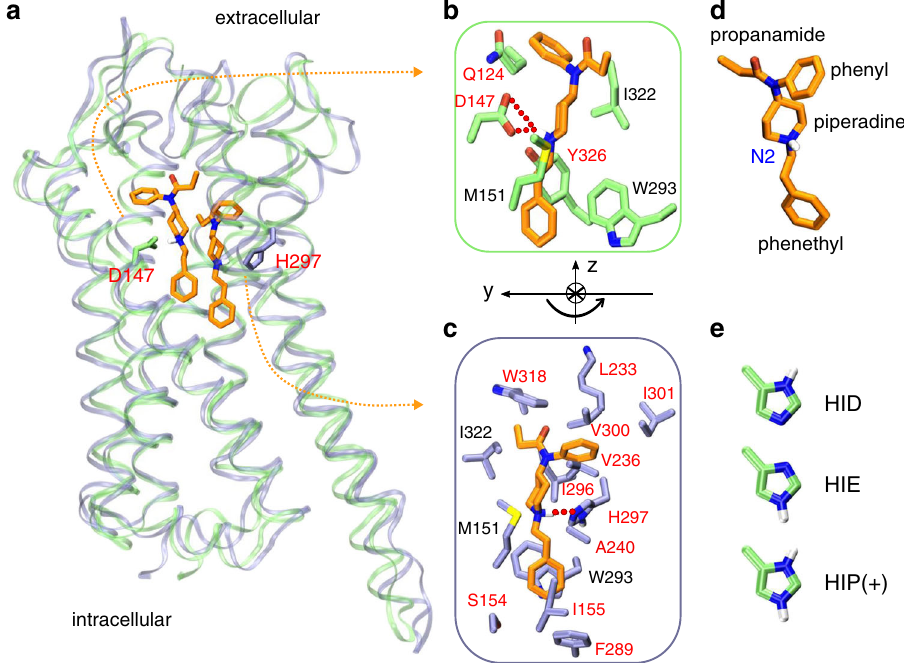
Fig. 1 Fentanyl binding with mOR. a Overlay of the representative simulation snapshots showing mOR is bound to fentanyl in the D147- (green) and H297- (purple) binding modes. b Zoomed-in view of the D147-binding mode, in which the charged piperidine amine of fentanyl forms a salt bridge with Asp147. c Zoomed-in view of the H297-binding mode, where the piperidine amine donates a proton to N ϵ of HID297. The curved arrow illustrates the change in the orientation of fentanyl in going from D147- to H297-binding mode. mOR residues making signi fi cant contacts with fentanyl (fraction greater than 0.5) are shown (see Fig. 4). Those unique to the two binding modes are labeled in red and otherwise in black. d Structure of fentanyl with different substituent groups and the protonated/charged amine labeled. e Histidine protonation states. HID and HIE are neutral while HIP is